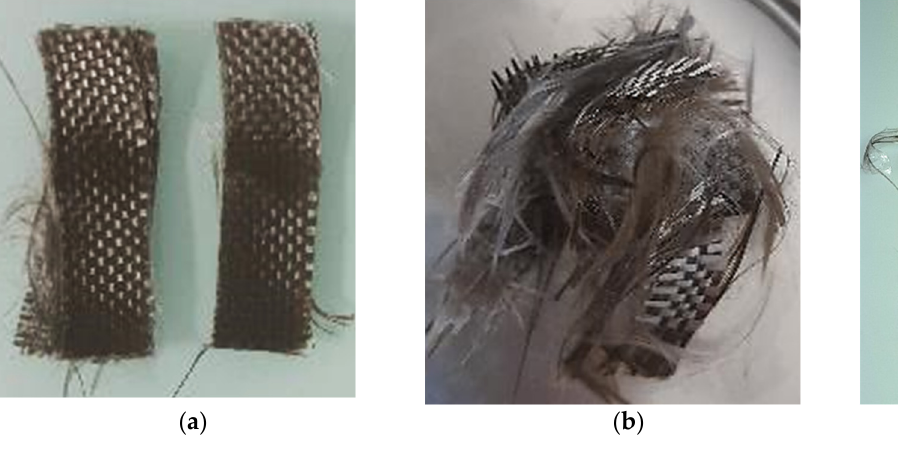
Figure 5. Basalt fibers recovered ( a ) after recycling 16 h with ultrasound at the beginning of the dissolution, ( b ) after recycling 7 h with ultrasounds at the end of the dissolution and ( c ) after recycling without ultrasounds. A 1:4 ratio is considered for each photo.